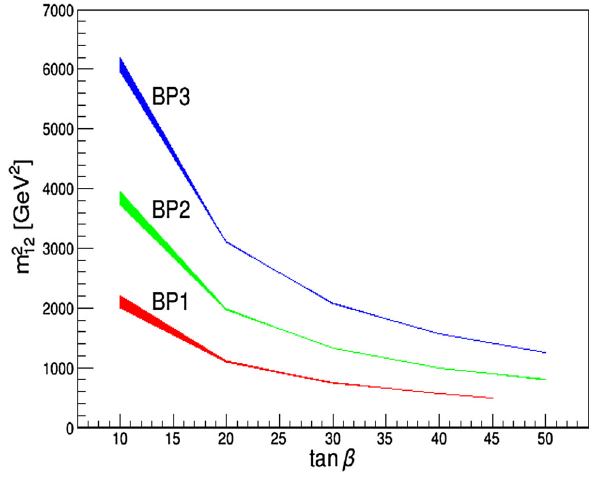
Fig. 5 The allowed m 2 values satisfying theoretical requirements as 12 a function of tan β for different benchmark points